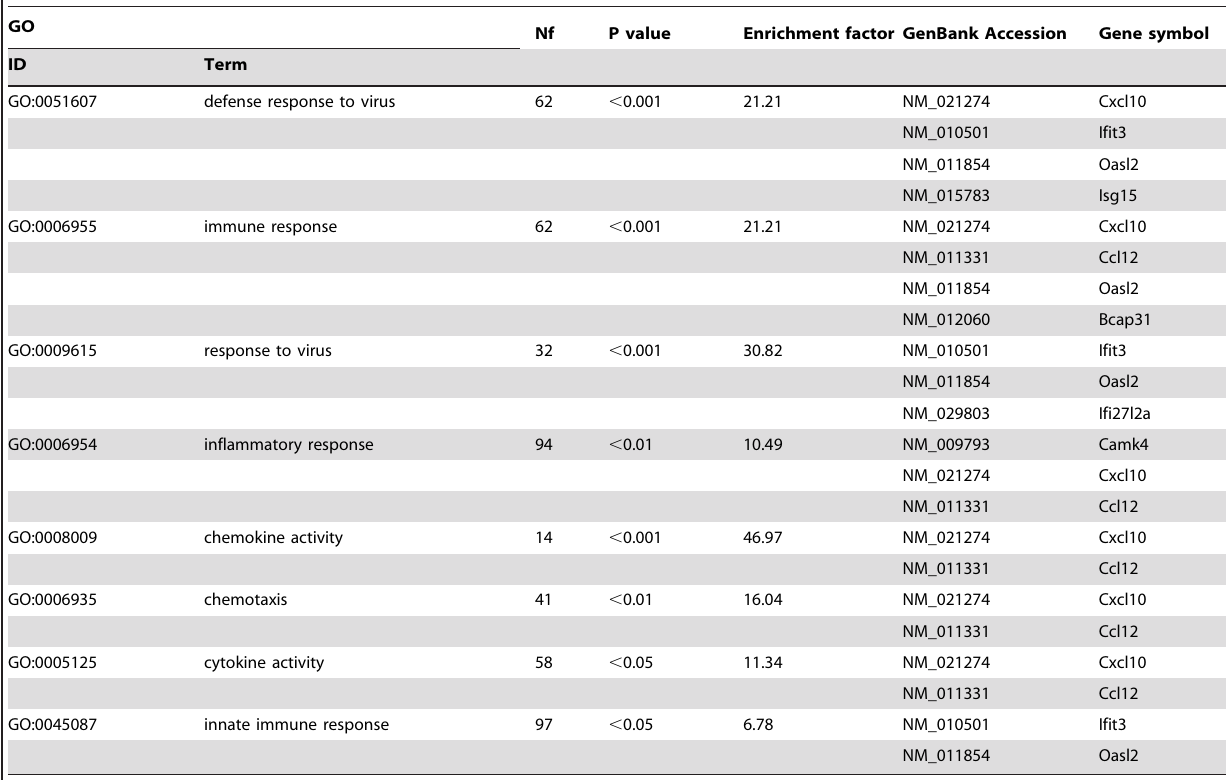
Table 4. Functional analysis of cluster A using Gene Ontology (GO).